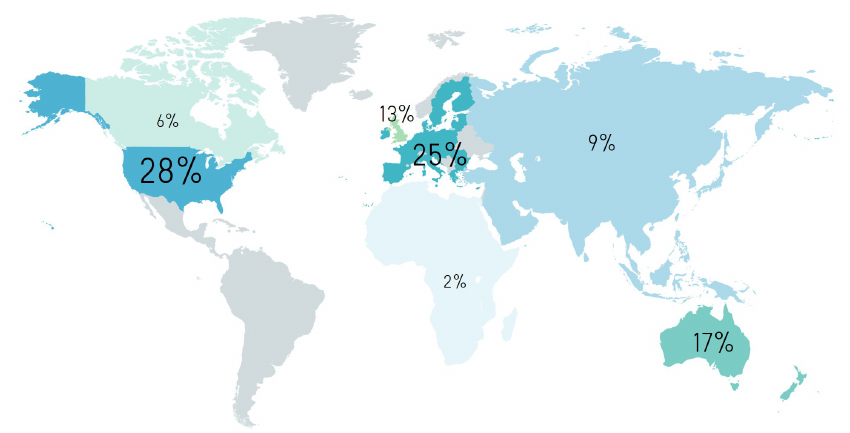
Figure 4. Geographical distribution of the 120 publications reviewed in this